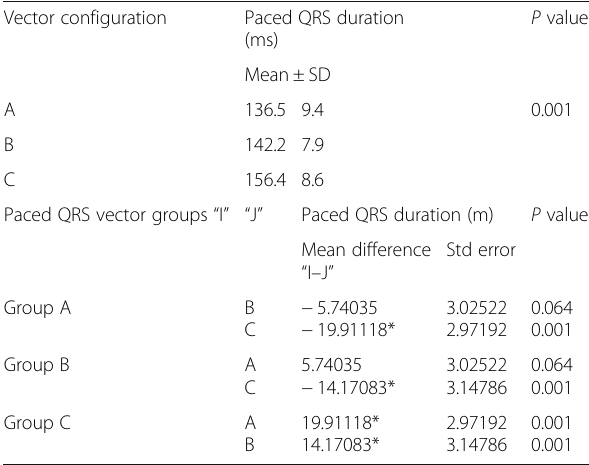
Table 2 Differences in paced QRS duration according to septal pacing site in the three groups